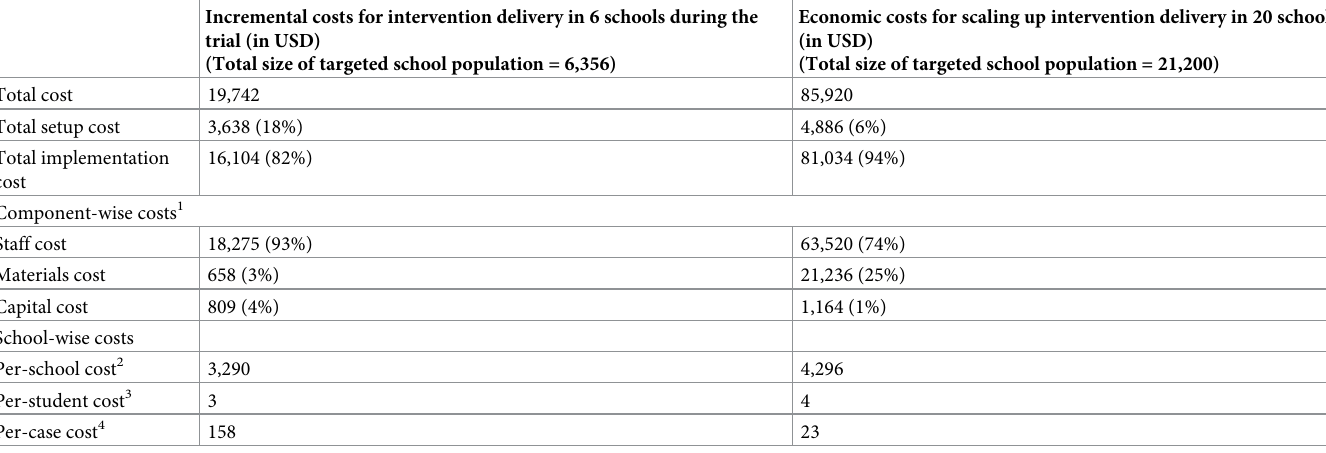
Table 3. Costs for delivering the counselor-led problem-solving intervention in the trial and in a scale-up scenario. Incremental costs for intervention delivery in 6 schools during the trial (in USD) (Total size of targeted school population =